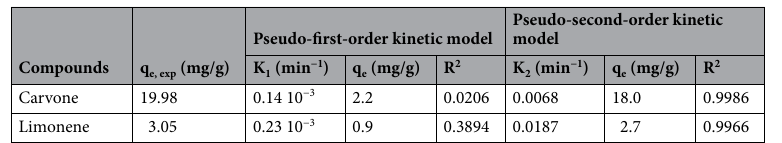
Table 4. Kinetic adsorption parameters according to the pseudo first and second-order models for Carvone and Limonene adsorption.